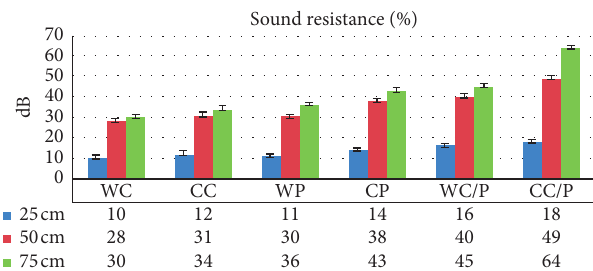
Figure 11: Sound resistance performance of recycled cotton/ polyester percentage values for the three-decibel values are shown in Figure 11.